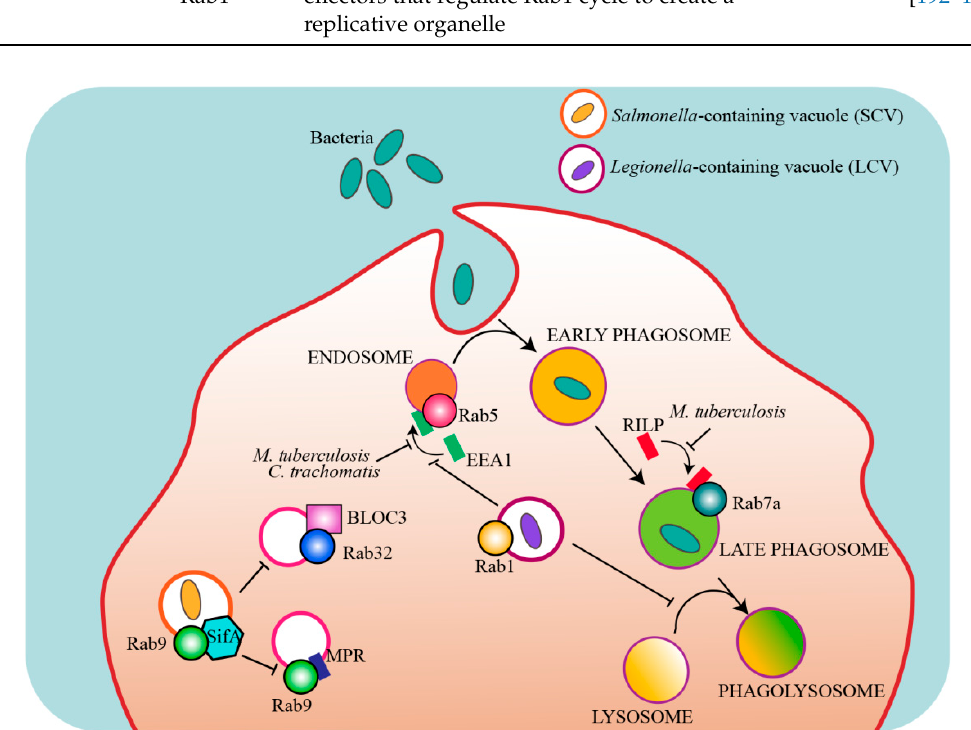
Figure 3. Rab proteins that are targeted by intracellular bacterial pathogens. Model showing the main Rab proteins and pathways that are targeted by intracellular bacterial e ff ectors to escape lysosomal degradation and establish a replicative organelle. EEA1: early endosome antigen-1, RILP: Rab-interacting lysosomal protein, BLOC-3: biogenesis of lysosome-related organelles complex-3, SifA: Salmonella-induced filament-A, MPR: mannose 6-phosphate receptor. Table 3. Intracellular bacteria that target Rab proteins.